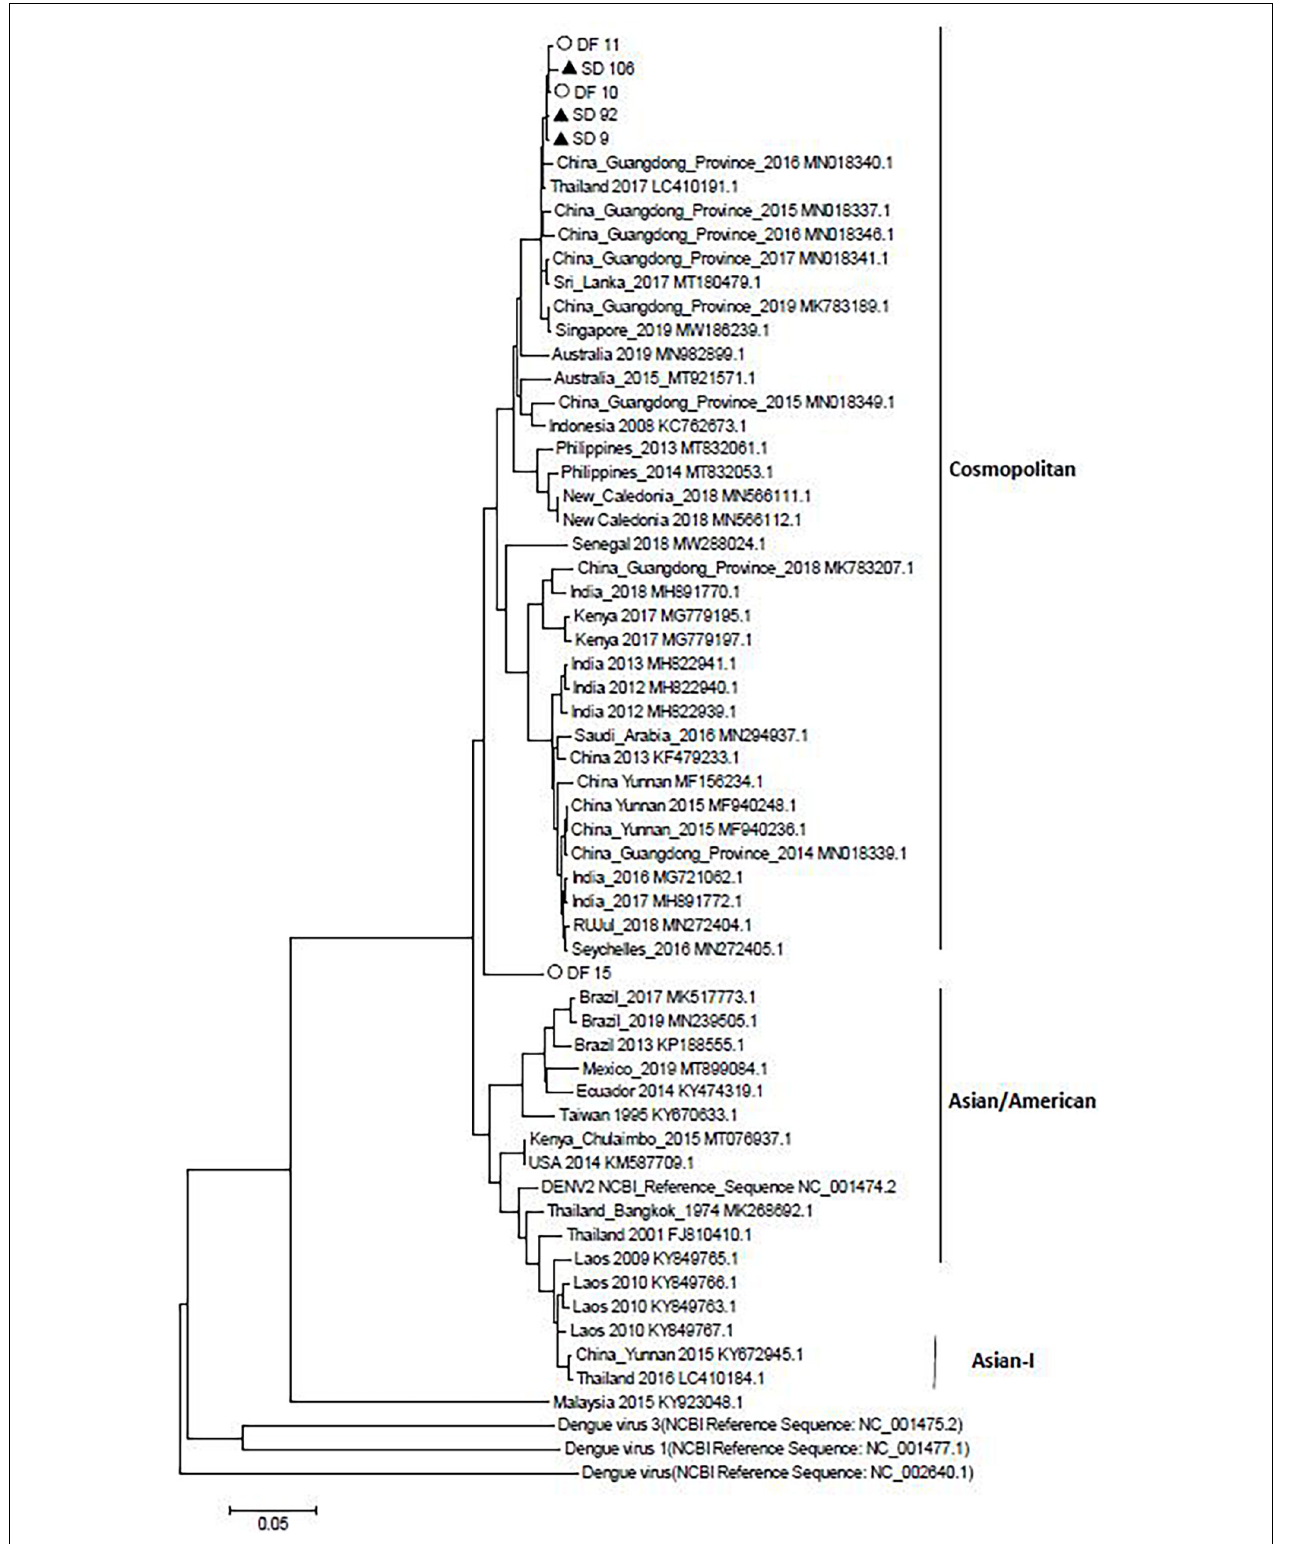
FIGURE 3 | Neighbor-joining phylogenetic tree generated using the nucleotide sequences of complete dengue virus sequences. Study sequences are labeled in black triangles or hollow circles. Others are standard sequences, including sequences of the DENV-2 subgenotype retrieved from the NCBI GenBank. Phylogenetic trees were constructed by the neighbor-joining method and the Kimura 2-parameter model by the MEGA package.